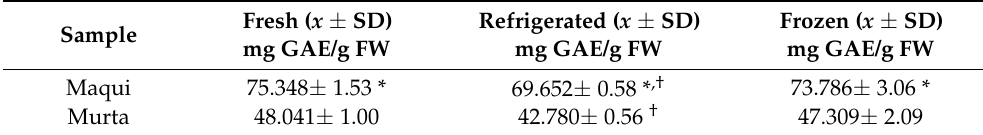
Table 2. Quantification values of TPC in maqui and murta by the Folin-Ciocalteu method in three categories of